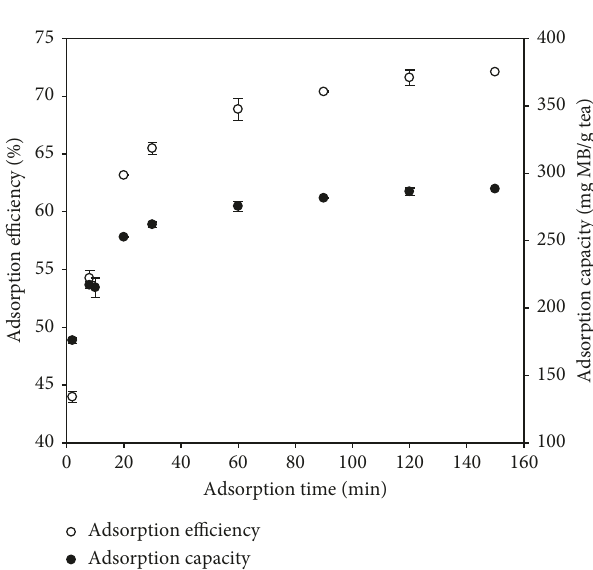
Figure 3: Effect of adsorption time on the adsorption efficiency and capacity of MB.